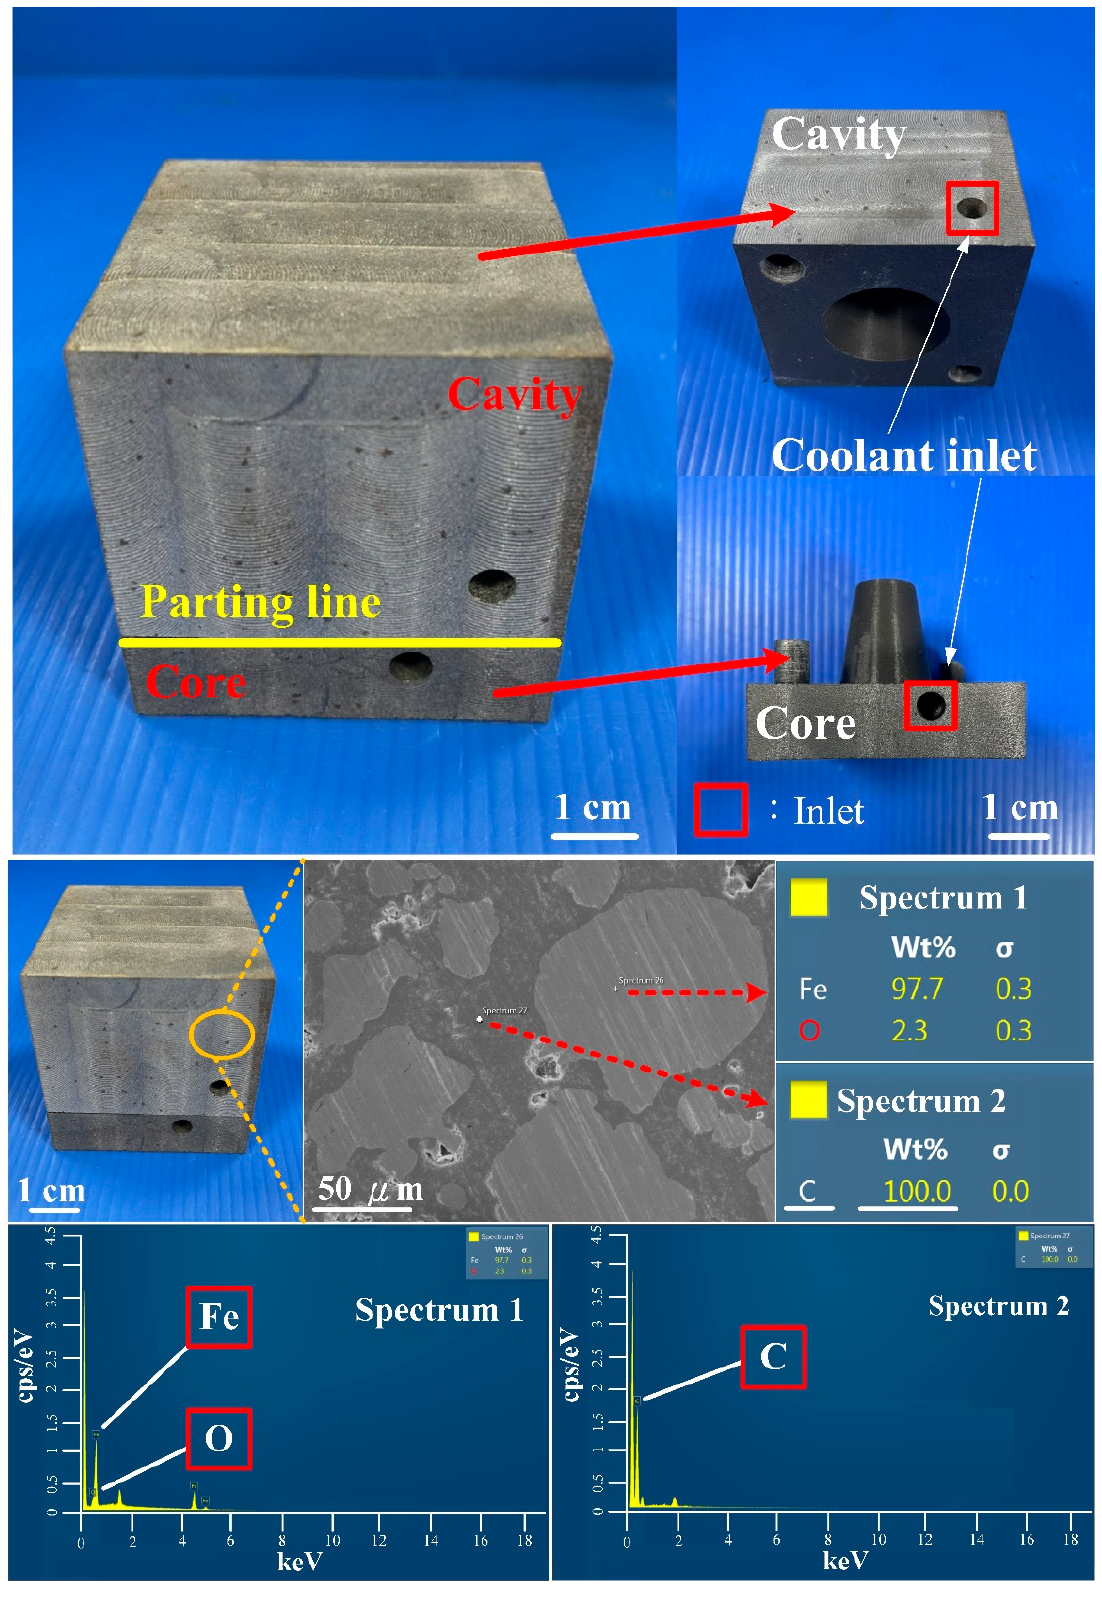
Figure 20. SEM micrographs and chemical composition of wax injection mold fabricated by epoxy resin added with 37 vol.% Fe powder.